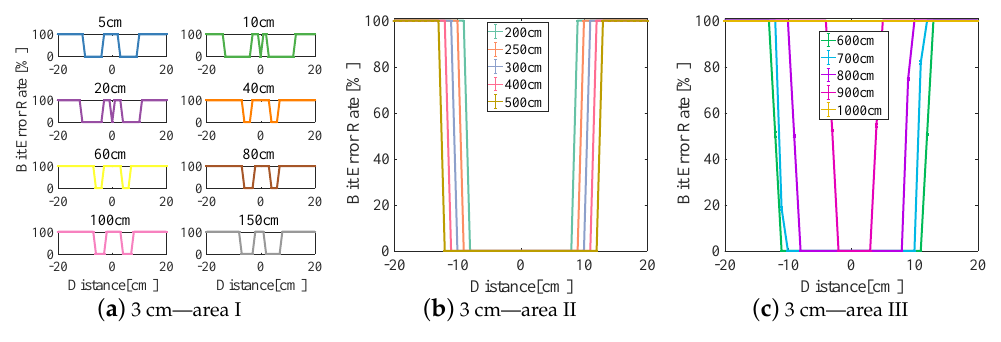
Figure 7. Lampshade height: 3 cm.